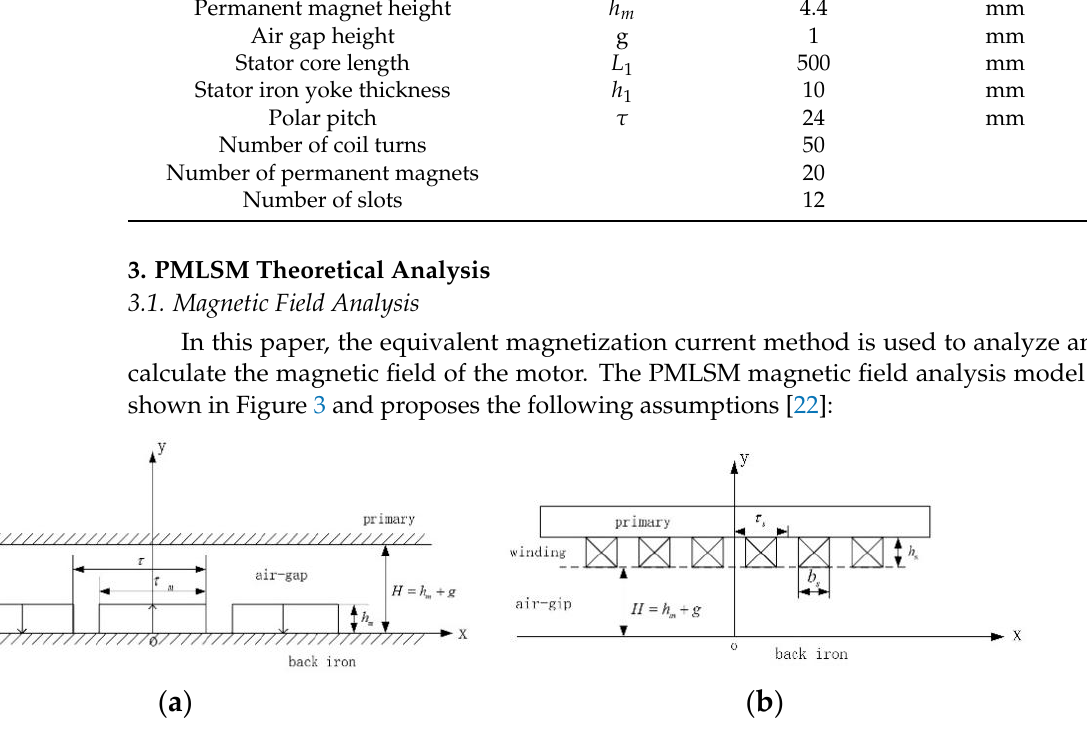
Figure 4. Distribution map of magnetization intensity of permanent magnets. According to the above assumptions, the magnetization intensity is expanded into each harmonic according to the Fourier series: M(𝑥) = 4𝐵 (cid:3045) 𝜋𝜇 (cid:2868) (cid:3533)(−1) (cid:3041)(cid:2878)(cid:2869)